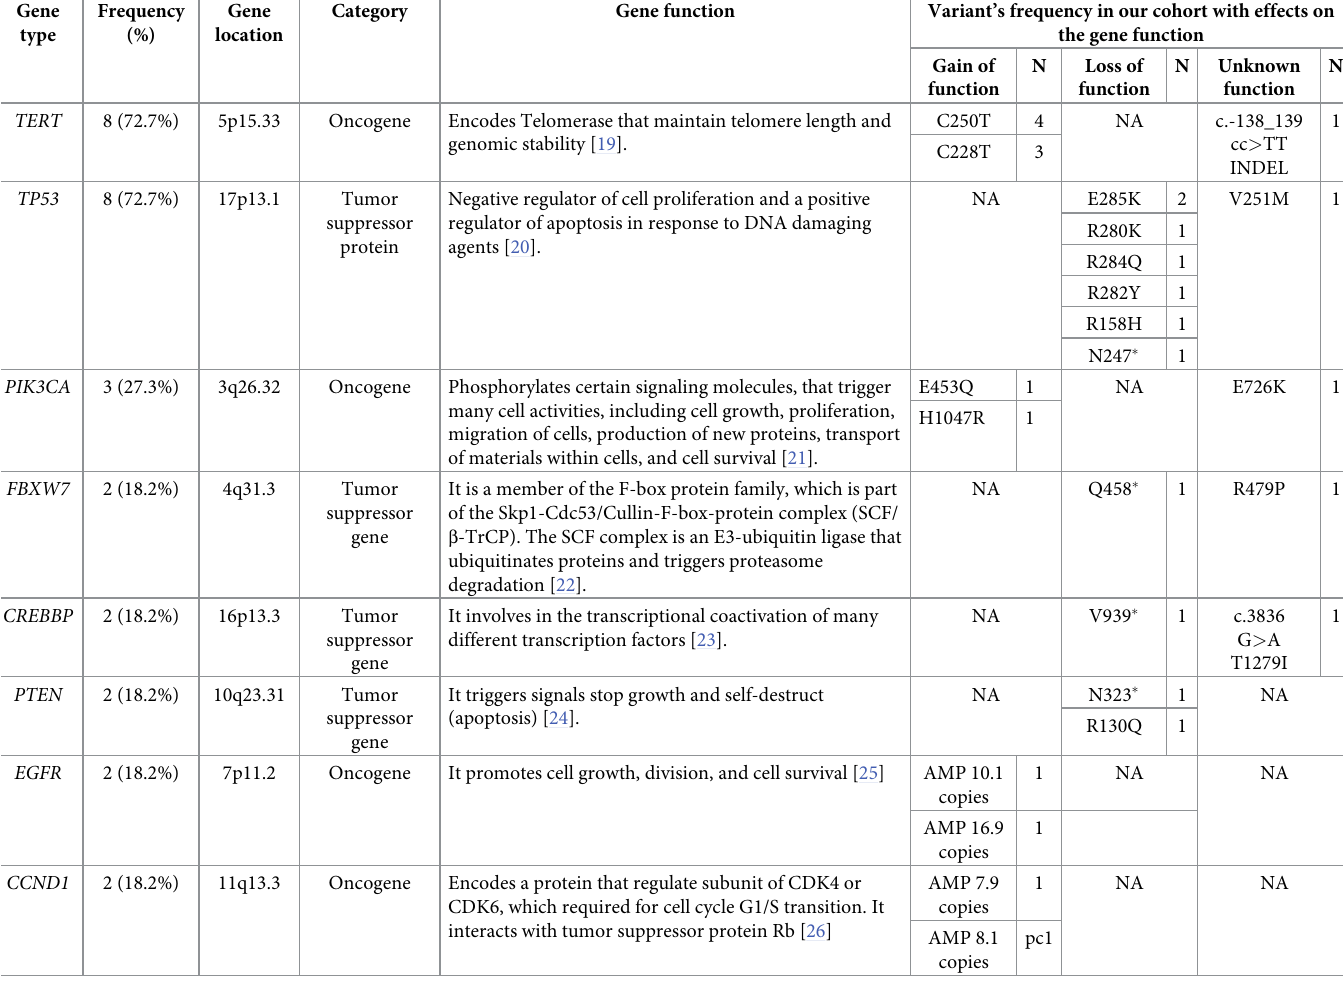
Table 3. The most common gene type, frequency, location, category, and the effects of variants on the gene function in our